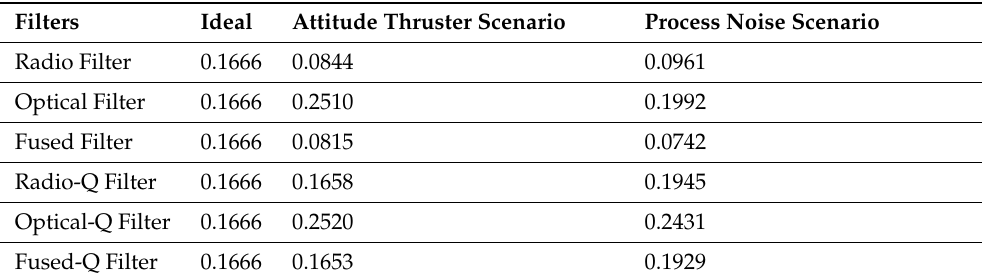
Table 4. Average Optimal Gating Network Weights for Mis-Modeled Dynamics